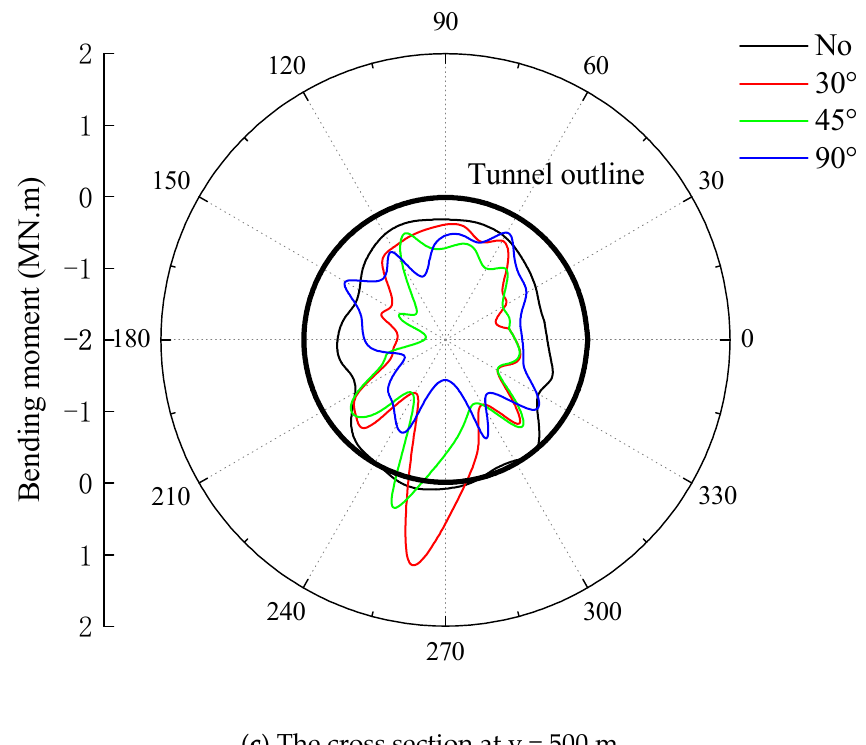
Figure 5. Bending moment of lining of the tunnel passing through adverse geological structure zone with different inclinations for each cross section along the tunnel axial direction. (It is noted that “No” represents that there is no adverse geological structure zone. Consistency means uniform seismic input and inconsistency means non-uniform seismic input).